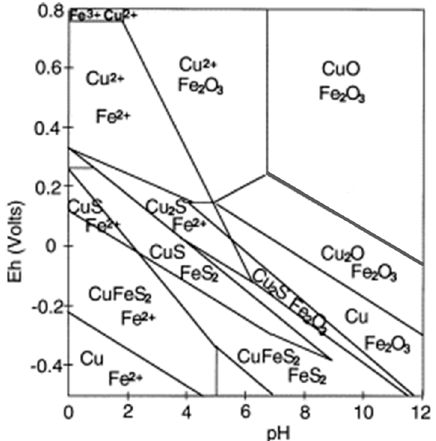
Figure 1. pH-Eh diagram for the Cu–Fe–S–H 2 O system with the preponderant copper and iron species shown in each domain [37].